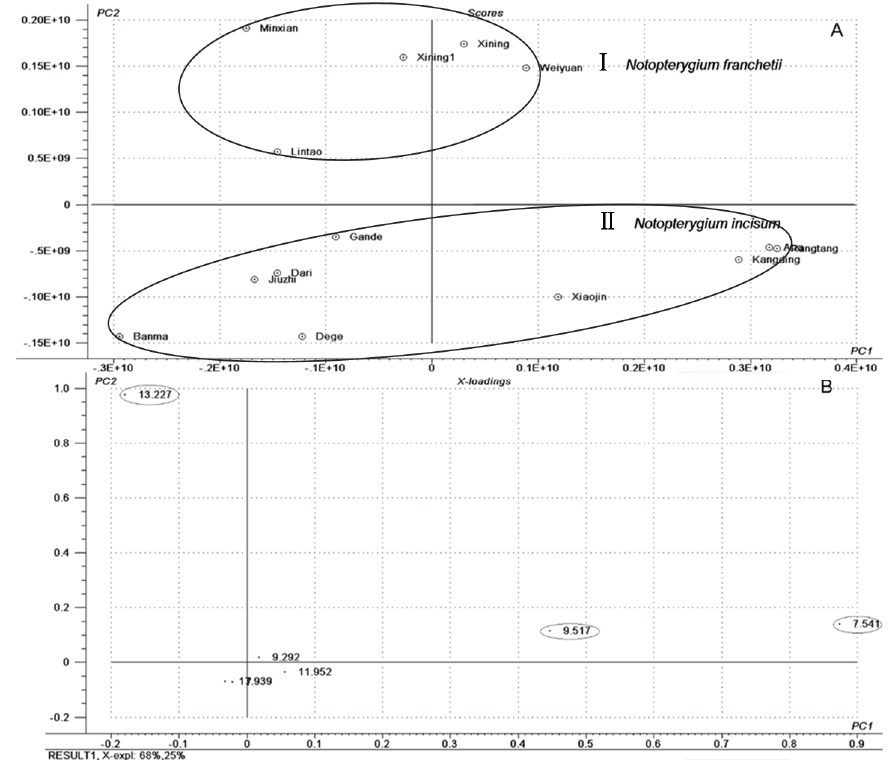
Figure 3. PCA scores plot ( A ) and loadings plot ( B ) for volatile oils in Qianghuo by